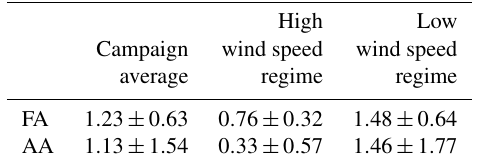
Table 1. Mean mixing ratios (in ppbv) of FA and AA for the en- tire campaign, the high wind speed regime, and the low wind speed regime ± one standard